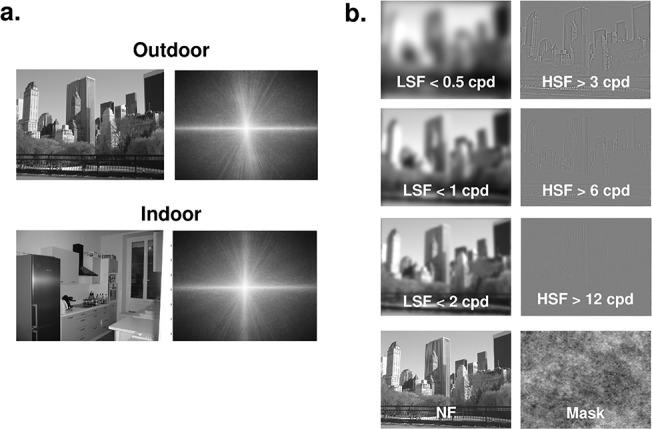
(a) Examples of scenes belonging to two different categories (outdoors and indoors) with the mean amplitude spectrum of each category. On the amplitude spectrum images, low spatial frequencies are close to the center and high spatial frequencies are on the periphery. Vertical orientations are represented on the x-axis and horizontal orientations on the y-axis. (b) Example of non-filtered scenes (NF), low-spatial frequency scenes (LSF) below 0.5, 1, and 2 cycles per degree (cpd), and high-spatial frequency scenes (HSF) above 3, 6, and 12 cpd.The mask used is also presented (bottom). It should be noted that the perception of spatial frequencies could be affected by picture reduction of scenes for illustrative purposes. In the experiment, picture size was about 10 times bigger than in this figure.